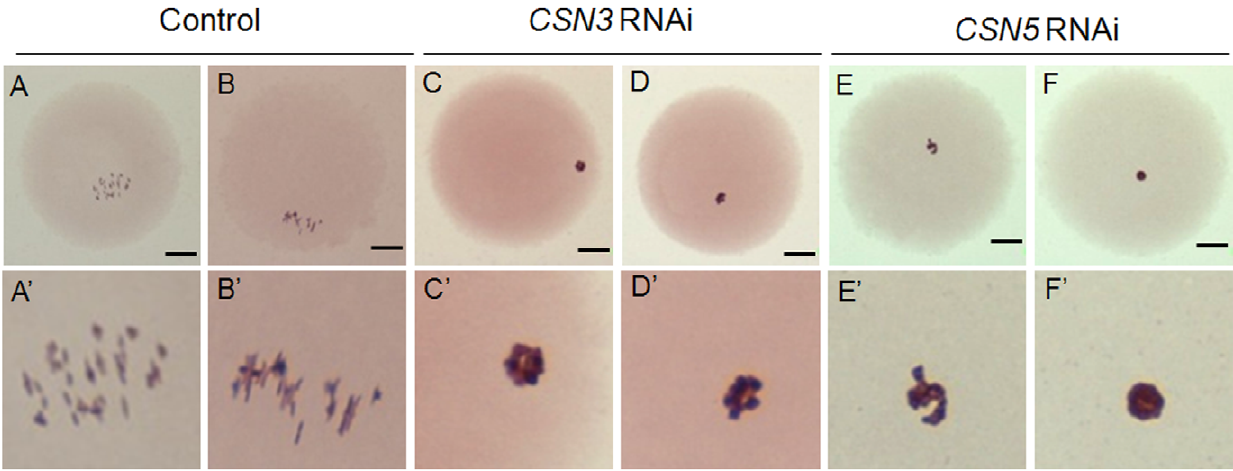
Figure 5. Down-regulation of CSN3 or CSN5 caused chromosome aggregation. (A, B) Control MI oocytes showing typical chromosome configuration. (C, D) CSN3 and (E, F) CSN5 RNAi-treated oocytes which were arrested at MI showed abnormally aggregated chromosomes. Upper panel (A–F), view of oocytes by optic microscopy ( 6 400); Lower panel (A 9 –F 9 ), Magnified view of upper panel. These microphotographs were digitally processed to increase magnification. Bars=25 m